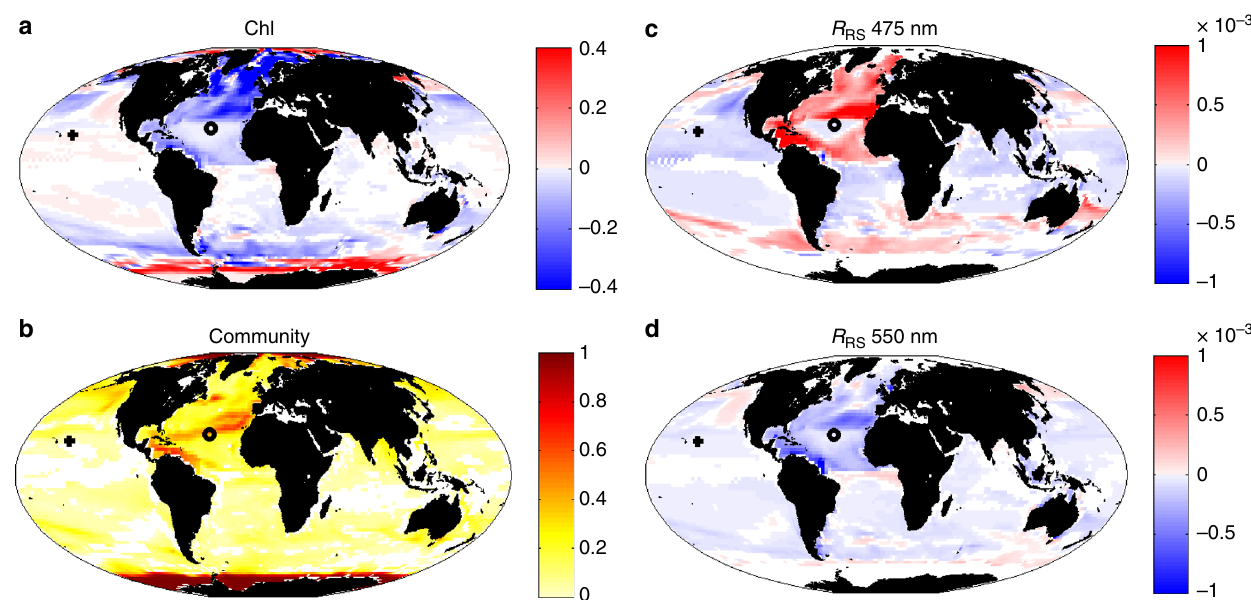
Fig. 4 Change between current day and end of the 21st century. a Difference in model actual Chl-a (mg Chl m − 3 ) between 2085 – 2100 mean and the current day (1998 – 2015) mean. b Change to phytoplankton community structure as de fi ned from Bray – Curtis dissimilarity index for community structure averaged over 2085 – 2100 versus the present day community (1998 – 2015). 0 indicates no change, 1 indicates a completely new community. Difference in model R RS 2085 – 2100 mean and the current day (1998 – 2015) mean for c 475 nm (blue) and d 550 nm (green). In all panels only areas with statistically signi fi cant differences between the two periods ( p < 0.05) are shown. In addition, in c and d we only show regions which were ice free for most of the year (i.e. open ocean where R RS was calculated) in the current day. The symbols ( + ,o) indicate two locations highlighted in Fig. 8